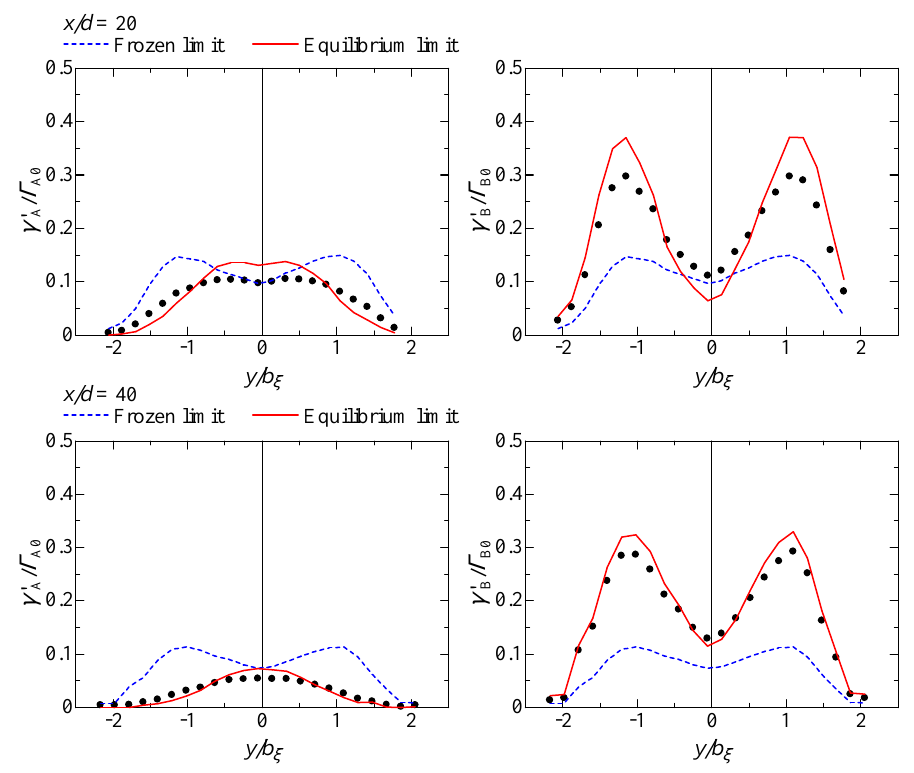
Fig. 13 The lateral profiles of the normalized mean concentrations of reactant A, ⟨ (cid:0) A ⟩ =(cid:0) A0 , and reactant B, ⟨ (cid:0) ⟩ =(cid:0) (cid:15) ) for Da = 11 : 7 at x = d = 20 and x = d = 40. The lateral profiles B B0 , obtained by the new system ( of the mean concentrations in the frozen limit (blue dashed lines) and the equilibrium limit (red solid lines) are shown together.